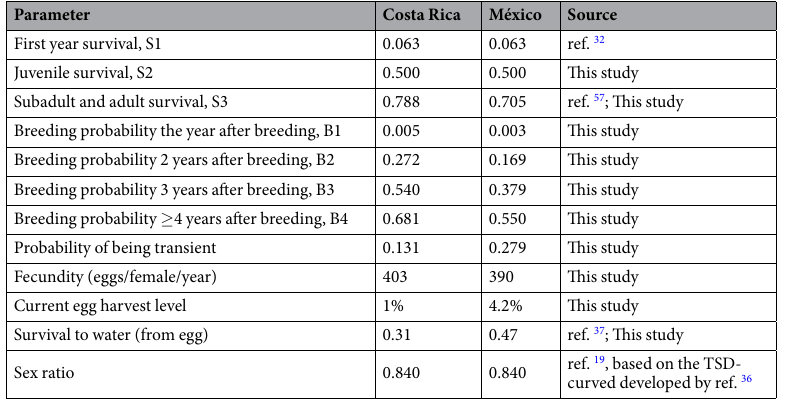
Table 1. Mean estimates used in the projection of current conditions obtained from this and previous studies. Stages referred to below appear in Fig. 2. First year and juvenile survival and fecundity, survival to the water and sex ratio were based on published estimates, while estimates for transient probability, survival probability and breeding propensity probabilities come from models with constant values to derive the variance-covariance matrix (Supplemental Table 1: models 23 and 5, for México and Costa Rica,